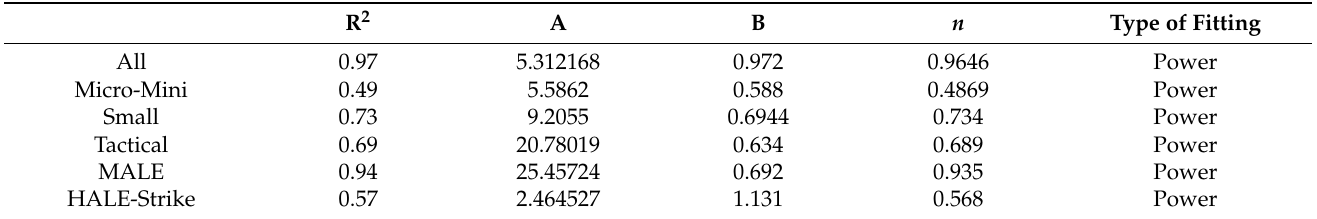
Table 6. Statistical data regarding the trend fitting for the GTOW as a function of payload weight